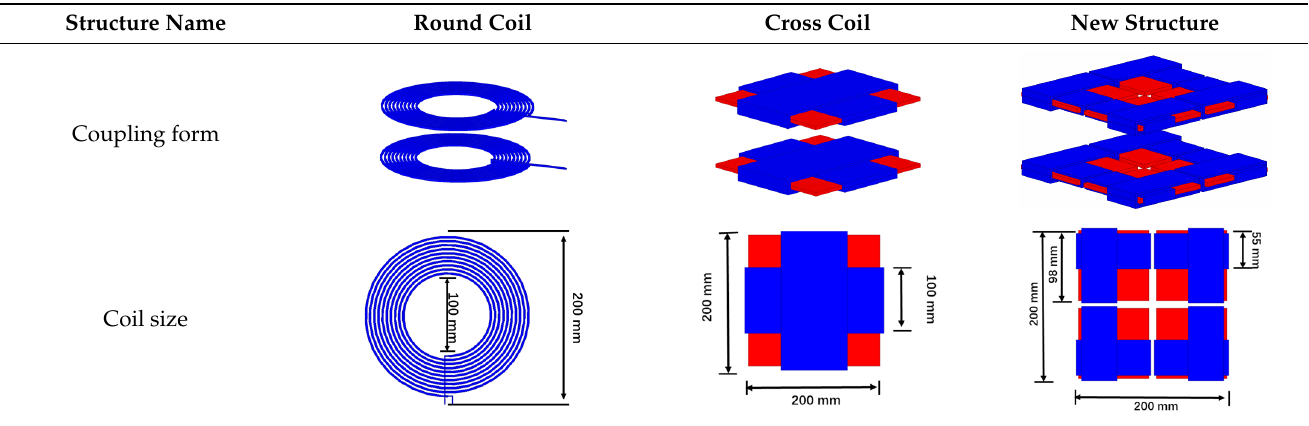
Table 1. Structural parameters of the simulated coil model.